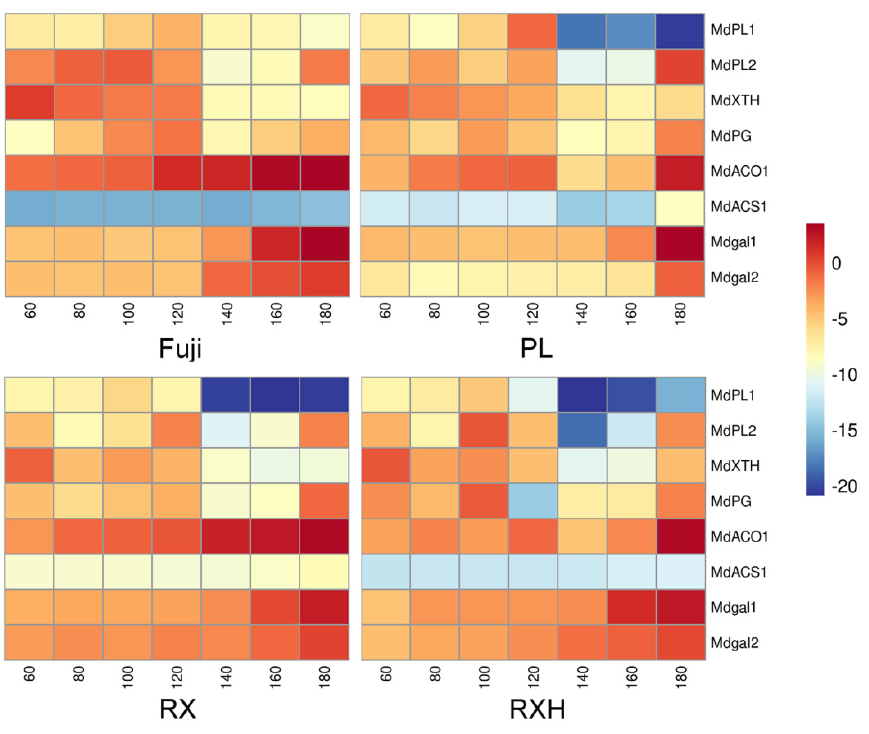
Figure 7. Expression heatmap of ethylene synthesis and cell wall hydrolytic-related genes for hardness decline during fruit development.